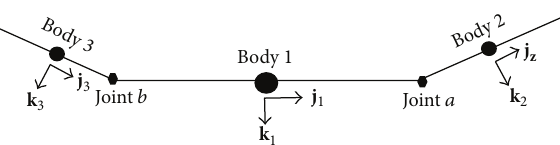
Figure 2: Schematic of the articulated MAV